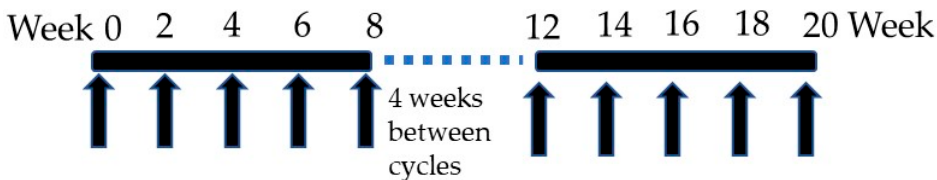
Figure 1. Schedule of Administration of NASVAC. NASVAC was given in two cycles. In the first cycle, the patients received NASVAC 5 times, once in two weeks, by intranasal administration. There was gap of 4 weeks between first and second cycles. In the second cycle, the patients received NASVAC both by intranasal and subcutaneous routes, 5 times.